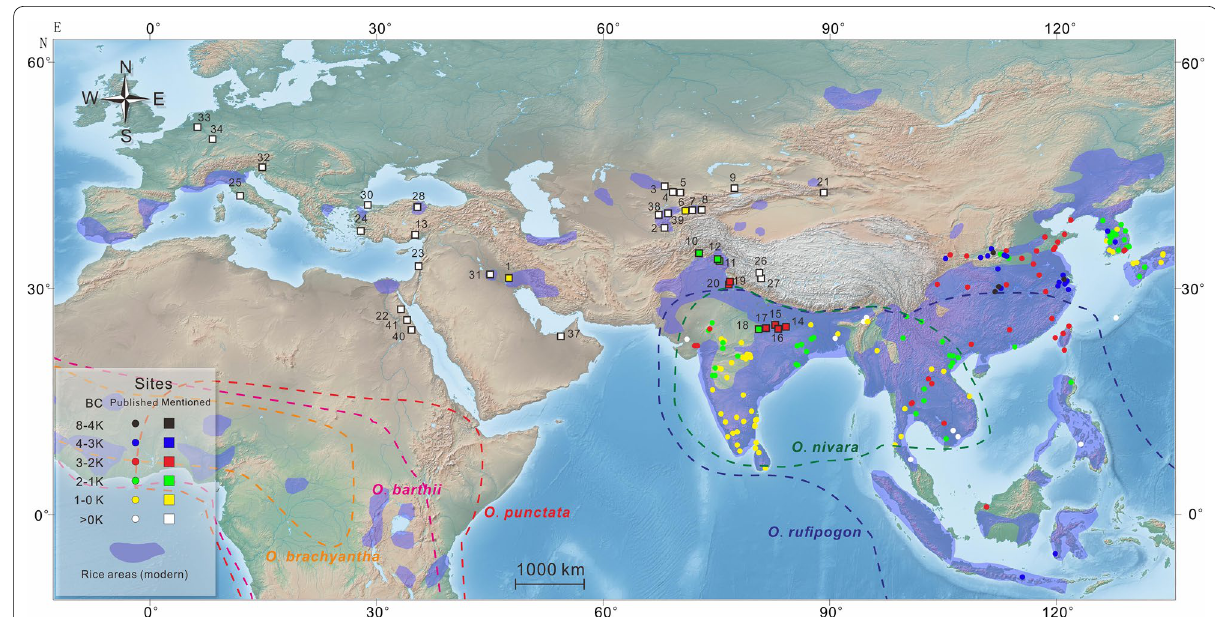
Fig. 1 Map illustrating the ancient dispersal of rice; blue shaded areas represent the range of modern rice cultivation as modified from Ray et al. (2012); modern range of wild rice species are indicated by dotted lines; (1) Susa (Strabo 1924 [7 BC‑AD 23]; Miller 1981); (2) Khalchayan ca. AD 250 (Chen et al. 2020); (3) Konyr‑tobe, seventh century AD (Bashtannik 2008); (4) Karaspan‑tobe, fourth to fifth century AD (Bashtannik 2008); (5) Djuvan‑tobe, seventh century AD (Bashtannik 2008); (6) Khujand (Sima 1993 [91–109 BC]); (7) Nos 28, 29, and 61, early first millennium AD (Gorbunova 1986); (8) Munchak Tepe, fifth to seventh centuries AD (Gorbunova 1986); (9) Paykend, ca. 1100 AD (Mir‑Makhamad et al. in review); (10) Barikot, ca 1200 BC (Spengler et al. 2020); (11) Semthan 1500–500 BC (Lone et al. 1993); (12) Gufkral and Bruzahon, ca. 1800–1000 BC